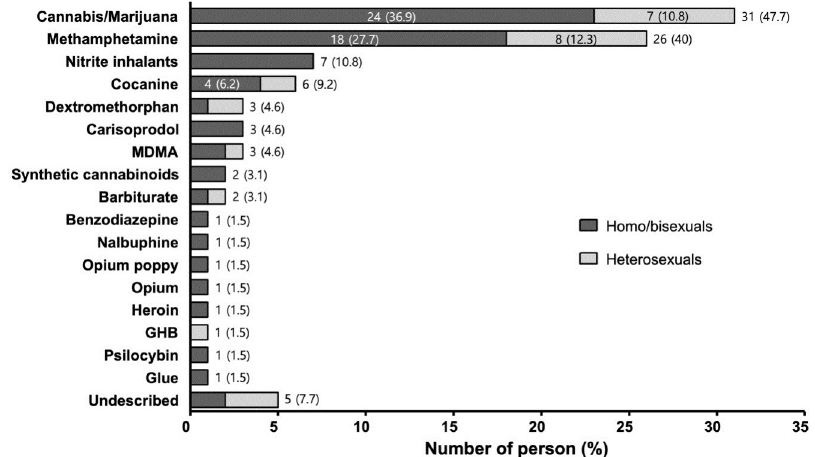
GHB, gamma hydroxybutyrate.